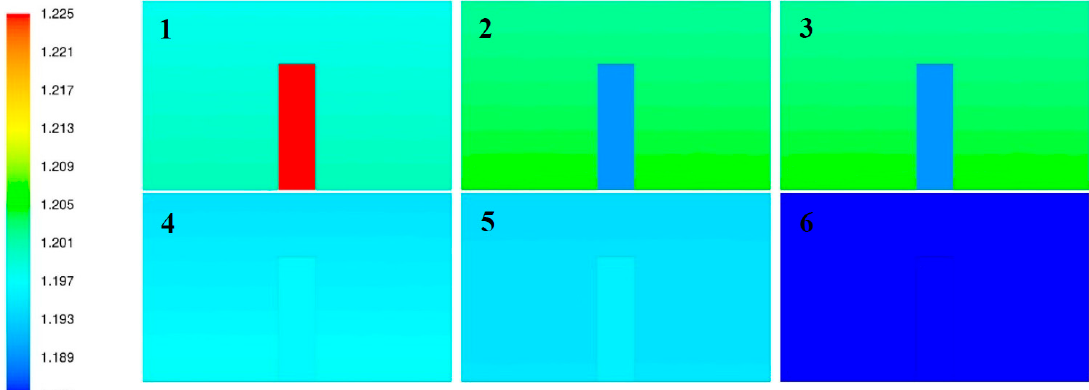
Figure 3. Initial conditions for numerical calculations—comparison of the density (1.185–1.225 g/m³) of air outside the chamber with the density of fire-extinguishing gas and air mixture inside the chamber; the scenario numbers refer to Table 1.